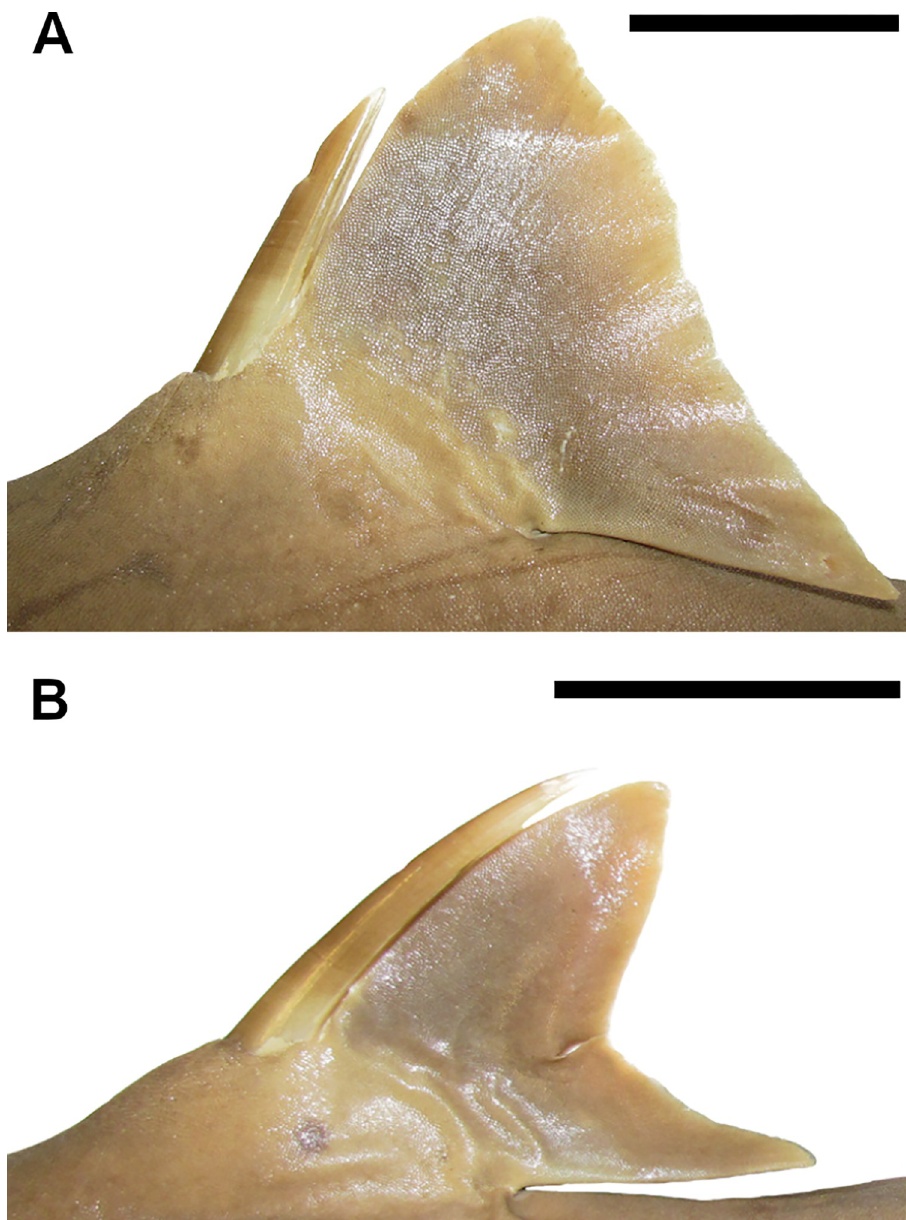
Fig 23. First (A) and second (B) dorsal fins of C . asper . A,B: BMNH 1972.10.10.1, adult male, 880 mm TL. Scale bars: 20 mm. dorsal-fin apex narrow and free rear tip pointed; first dorsal fin conspicuously tall, its height 1.3 (1.0–1.5) times greater than preorbital length and 1.6 (1.4–2.1) times greater than inner margin length of first dorsal fin. First dorsal-fin spine thick (its base width 1.1%, 0.6%–1.5% TL) and markedly elongate, its length 5.7% (1.9%–7.6%) of TL; first dorsal-fin spine not reach- ing the fin apex, its length 0.7 (0.2–0.8) times height of first dorsal. Interdorsal space almost equal to prepectoral length, corresponding to 1.1 (0.8–1.6) times the latter and 2.4 (2.0–3.0) times larger than dorsal-caudal space. Origin of second dorsal fin